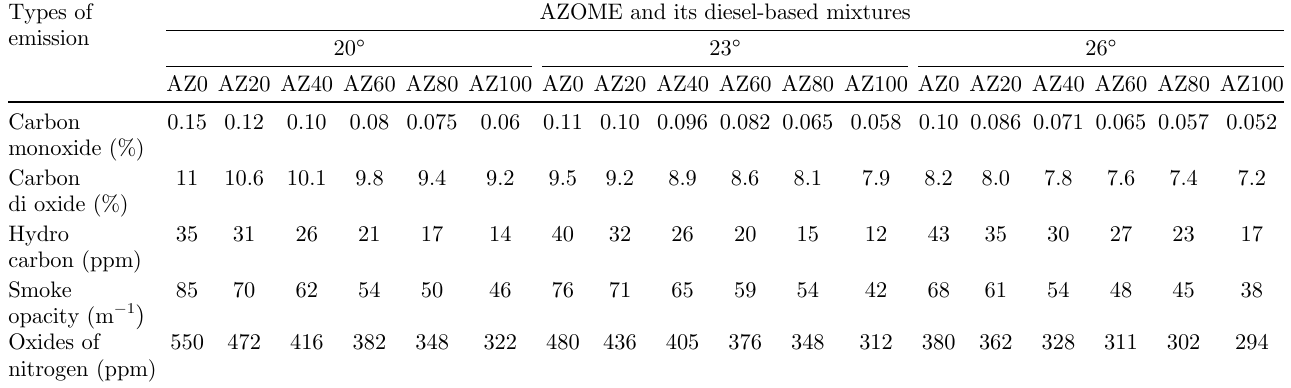
Table 4. Emissions at full